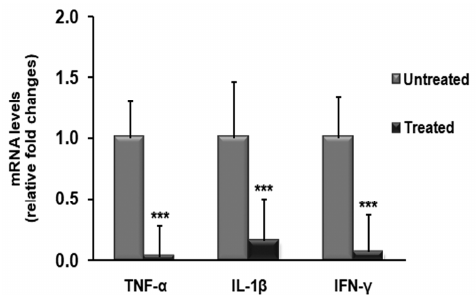
Figure 1. Changes in mRNA levels of cytokines in foreskin tissues from patients with balanitis xerotica obliterans (BXO) untreated or treated with OZOILE ® . The results are the means of data obtained from 15 untreated patients and 15 treated patients. Error bars represent standard error of the mean (SEM). *** p < 0.001 significant differences in comparison with untreated patients.